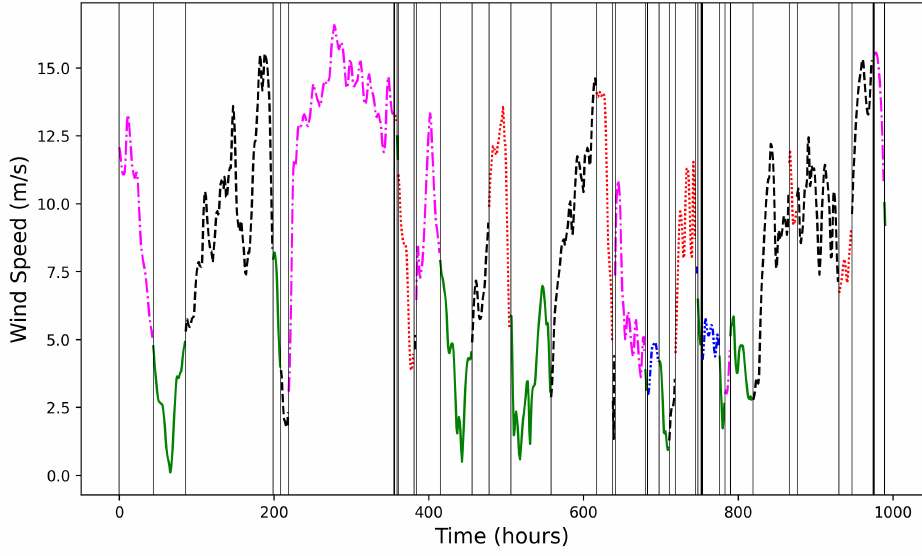
Figure 1. The Dirichlet process